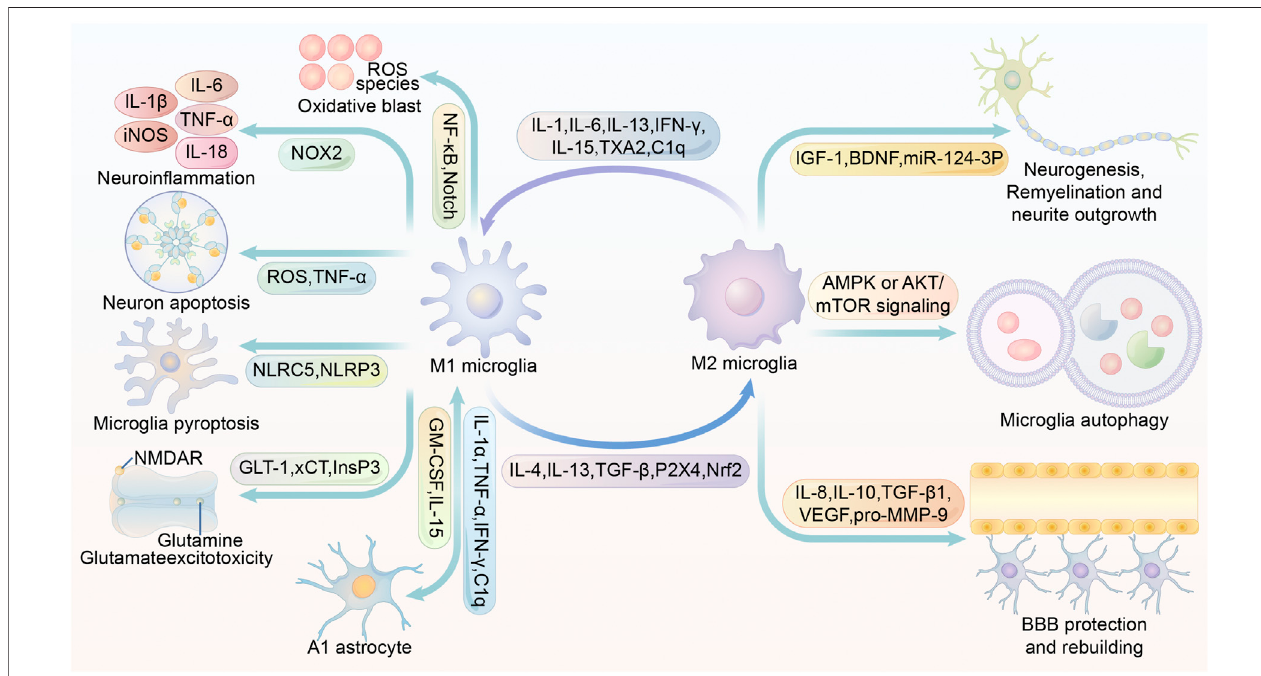
FIGURE2| MultiplerolesofM1/M2microgliainstrokemodulation.IL-1,IL-6,IL-13,IFN- γ ,IL-15,TXA2andC1qpromotemicrogliaM1polarizationorM2microglia conversiontoM1.IL-4,IL-13,TGF- β ,P2X4andNrf2promotemicrogliaM2conversionorM1microgliaconversiontoM2.ActivationofNF- κ BandNotchinM1microglia promotesin fl ammatoryfactorproduction.activationofNOX2inM1microgliapromotesROSproduction.M1microgliaareabletosecreteROSandTNFandthusinduce neuronalapoptosis.activationofNLRP3andNLRC5inM1microgliamaycontributetomicrogliascorching.TheinhibitionofInsP3receptorsfacilitatestheinhibition ofglutamate release. M1microgliasecrete IL-1 α ,TNF- α ,IFN- γ ,C1q topromote the A1phenotype ofastrocytes. A1phenotype astrocytessecrete GM-CSF and IL-15to promote microglia M1 polarization. glial cell M1 polarization. IL-4, IL-13, TGF- β , P2X4, Nrf2 induce microglia M2 polarization. M2 microglia promote neurogenesis, remyelination and neurite outgrowth by secreting IGF-1, BDNF and miR-124-3p-containing exosomes. Increased AMPK or AKT/mTOR signaling promotes microglia autophagy,andenhanced autophagyiscloselyassociatedwithmicrogliaM2polarization.M2microgliapromoteBBBprotectionand rebuildingbysecreting IL-8,IL-10, TGF- β 1, VEGF and pro-MMP-9. Abbreviations: iNOS, inducible nitric oxide synthase; TNF- α , tumour necrosis factor α ; ROS, reactive oxygen species; NF- κ B, Nuclear factorkappaB;NMDAR,N-methyl-D-asparticacidorN-methyl-D-aspartatereceptor;NOX2,NADPHoxidase2;NLRC5,NOD-,LRR-andCARD-containing5;NLRP3, NOD-likereceptorprotein3;GLT-1,glutamatetransporter-1;xCT,cystine/glutamateantiporter;InsP3,inositol1,4,5-trisphosphate;GM-CSF,granulocyte-macrophage colony-stimulating factor; TXA2, thromboxane A2; TGF- β , tumor growth factor- β ; Nrf2, Nuclear factor erythroid 2-related factor; IGF-1, insulin-like growth factor 1; BDNF,brain-derivedneurotrophicfactor;AMPK,AMP-activatedproteinkinase;mTOR,mammaliantargetofrapamycin;VEGF,vascularendothelialgrowthfactor;BBB, blood-brain